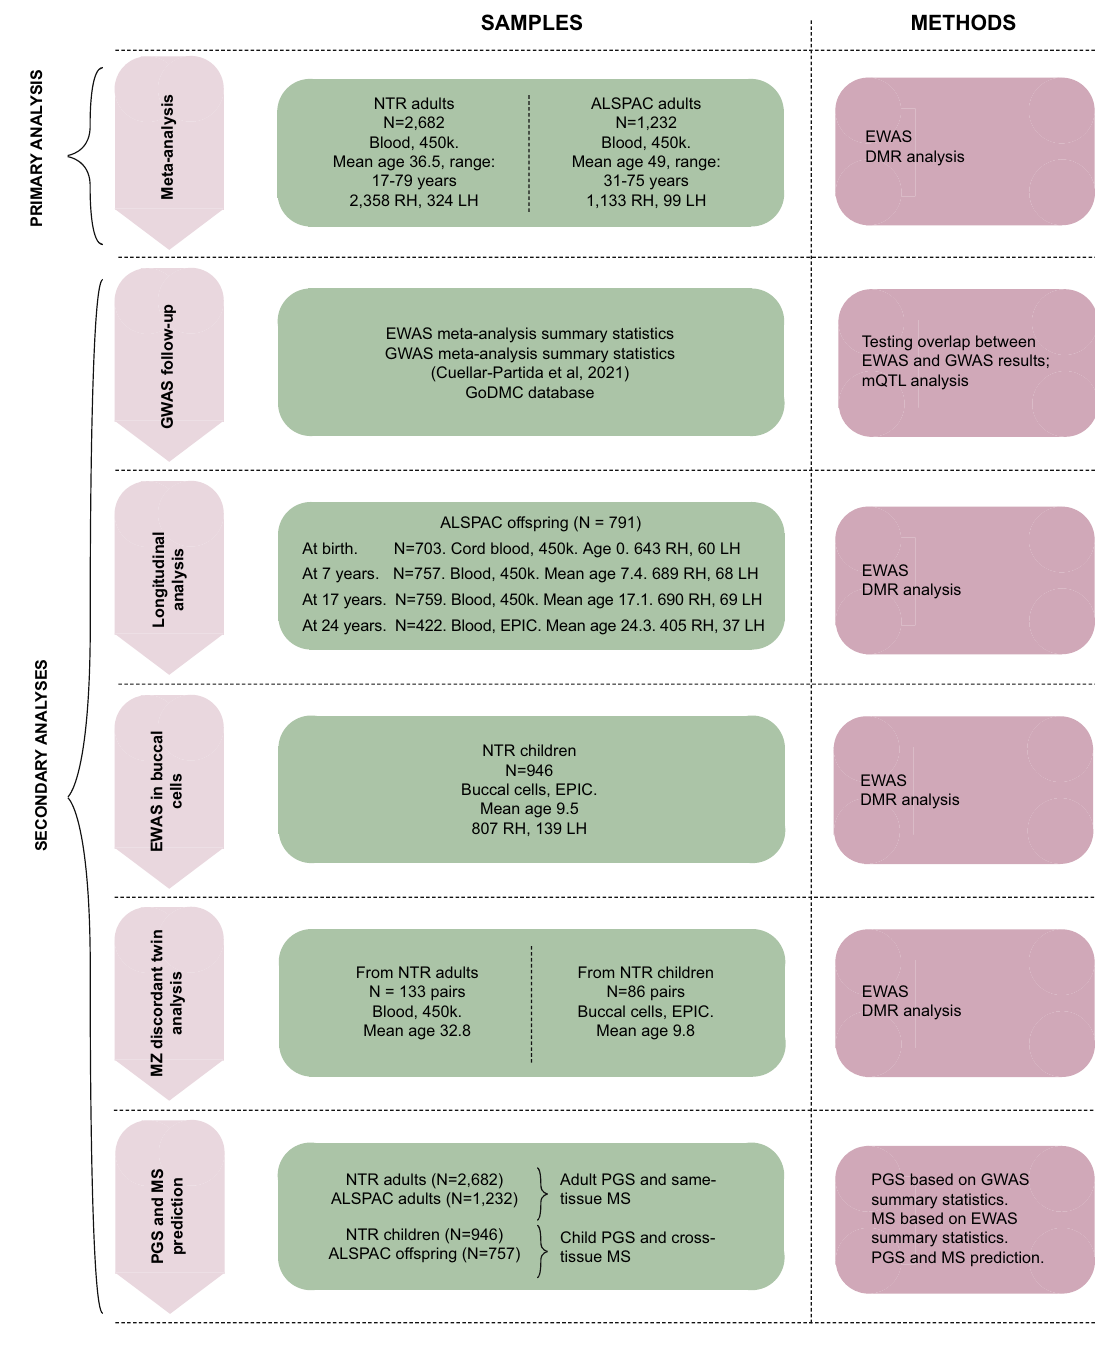
Figure 1. Flowchart of epigenome-wide association study of left-handedness. The flowchart summarizes the study design. The primary analyses included EWASs in NTR adults and ALSPAC adults, followed by meta- analysis to identify DNA methylation sites associated with left-handedness. The secondary analyses included: (1) left-handedness GWAS loci follow-up; (2) longitudinal analysis of DNA methylation at four ages in ALSPAC offspring; (3) analysis of buccal cell DNA methylation in NTR children; (4) analysis of DNA methylation differences between left and right-handed co-twins from NTR discordant MZ twin pairs and (5) polygenic and DNA methylation scores prediction. For left-handedness prediction, polygenic scores (PGS) were created based on left-handedness GWAS summary statistics not including NTR/ALSPAC. Methylation scores (MS) were created based on weights from EWASs in NTR adults, ALSPAC adults, NTR children and ALSPAC offspring at 7 years old to estimate the predictive performance. LH, left-handed; RH, right-handed. DMR, differentially methylated region. EWAS, epigenome-wide association study. GWAS, genome-wide association study. GoDMC, Genetics of DNA Methylation Consortium. mQTL, methylation quantitative trait locus. Blood, buccal cells indicate tissue of DNA methylation. 450 k, EPIC indicate the platform for DNA methylation